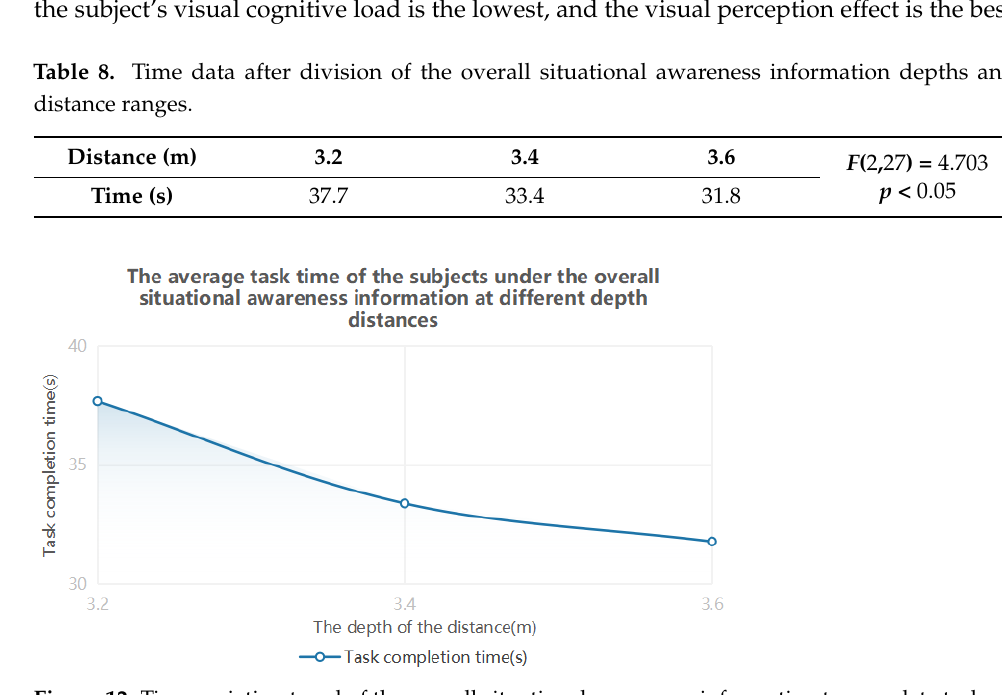
Table 9. The average eye movement data after dividing the overall situational awareness infor- mation depth and distance range.